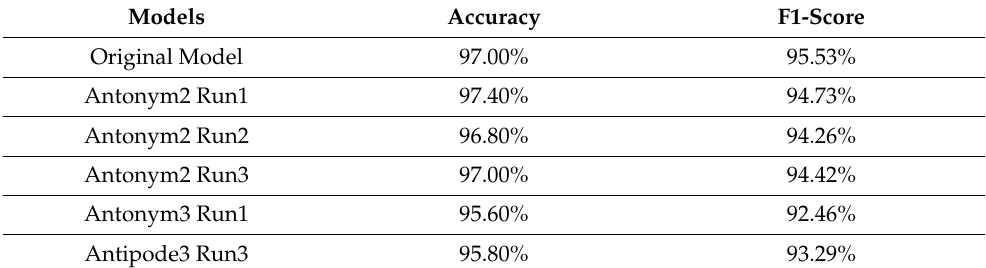
Table 3. Target Models on TREC.